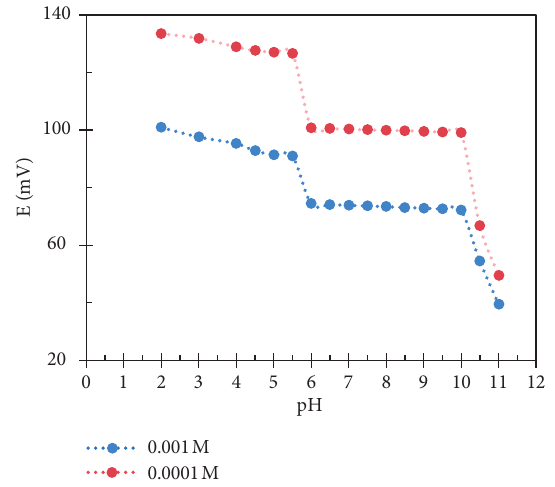
Figure 4: Effect of pH on potentiometric response for the MON.Cd. sensor.